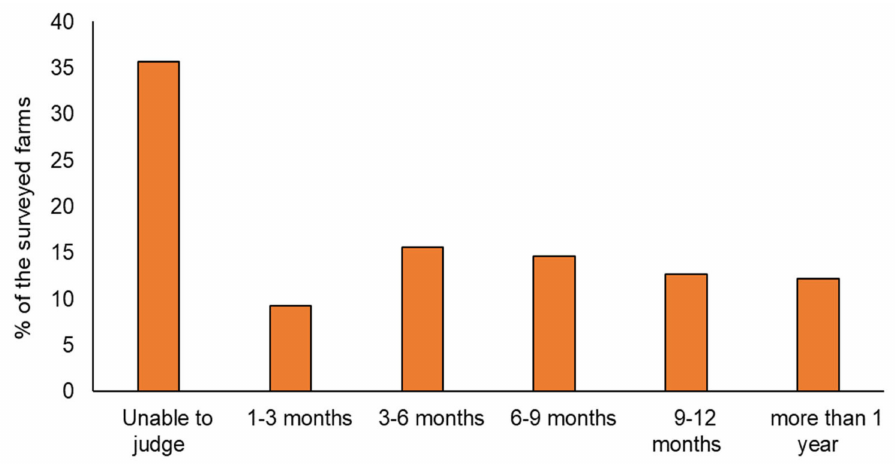
Figure 3. Anticipated duration for broiler farming business to return to normal, as anticipated by the farms surveyed ( n =